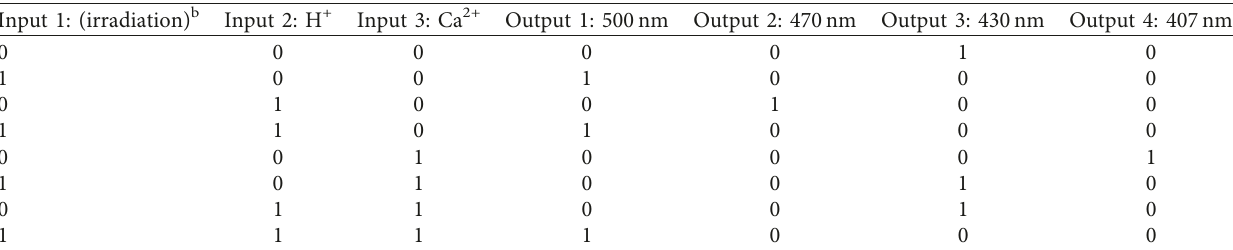
results in enrichment of the trans isomer.